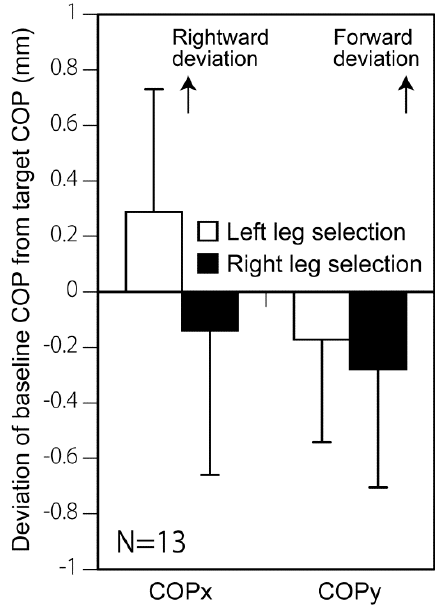
Figure 5. The deviation of the baseline COP from the target COP during gait initiation with the left and right legs in the off-TMS condition in the TMS session. The bars indicate the mean and the error and right legs in the o ff -TMS condition in the TMS session. The bars indicate the mean and the error bars indicate the standard errors of the mean. There was no significant difference in the baseline COP bars indicate the standard errors of the mean. There was no significant di ff erence in the baseline COP between gait initiation with the left leg and that with the right leg. between gait initiation with the left leg and that with the right